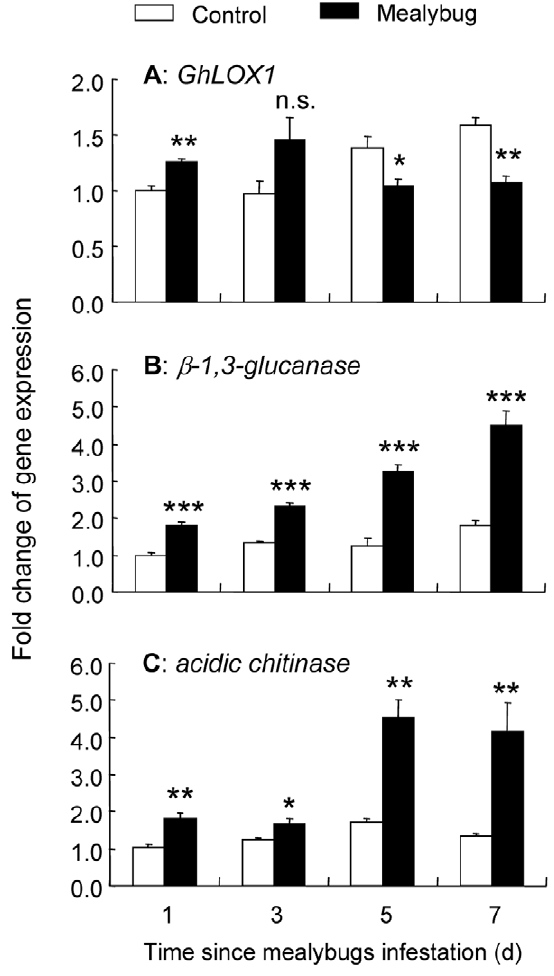
Figure 5. Time-related changes in expression of GhLOX1 (A), b -1,3-glucanase (B), acidicchitinase (C) in response to mealybugs feeding in cotton. The relative gene expression was calculated using the comparative 2 2 DD Ct method with GhACT4 as endogenous control gene. Values are shown as the mean ( 6 SE) of three biological replicates. Asterisks represent significant differences from control plants as determined by Fisher’s PLSD test of ANOVA ( * P , 0.05; ** P , 0.01; *** P , 0.001; n. s.=not